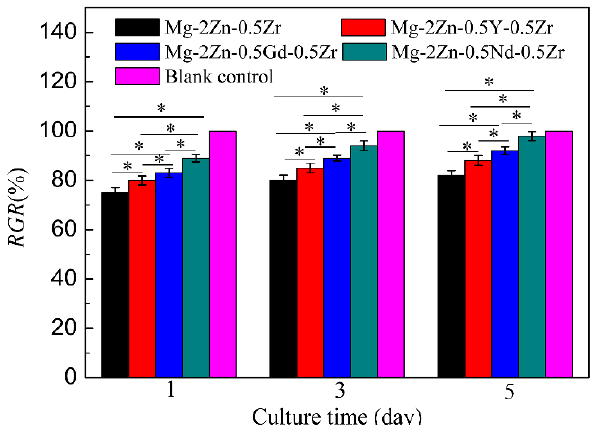
Figure 14. Cell viability of MC3T3-E1 cells after culturing with extracts of different alloys for 1, 3 and 5 days ( * p < 0.05).